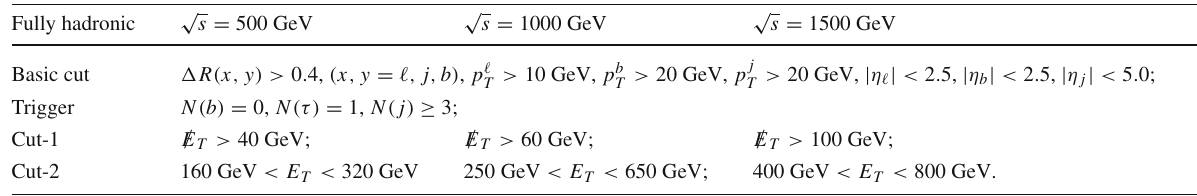
Table 9 Cut flows of the signal and backgrounds at m τ (cid:2)± = 200 GeV, √ s = 500 GeV Fully hadronic